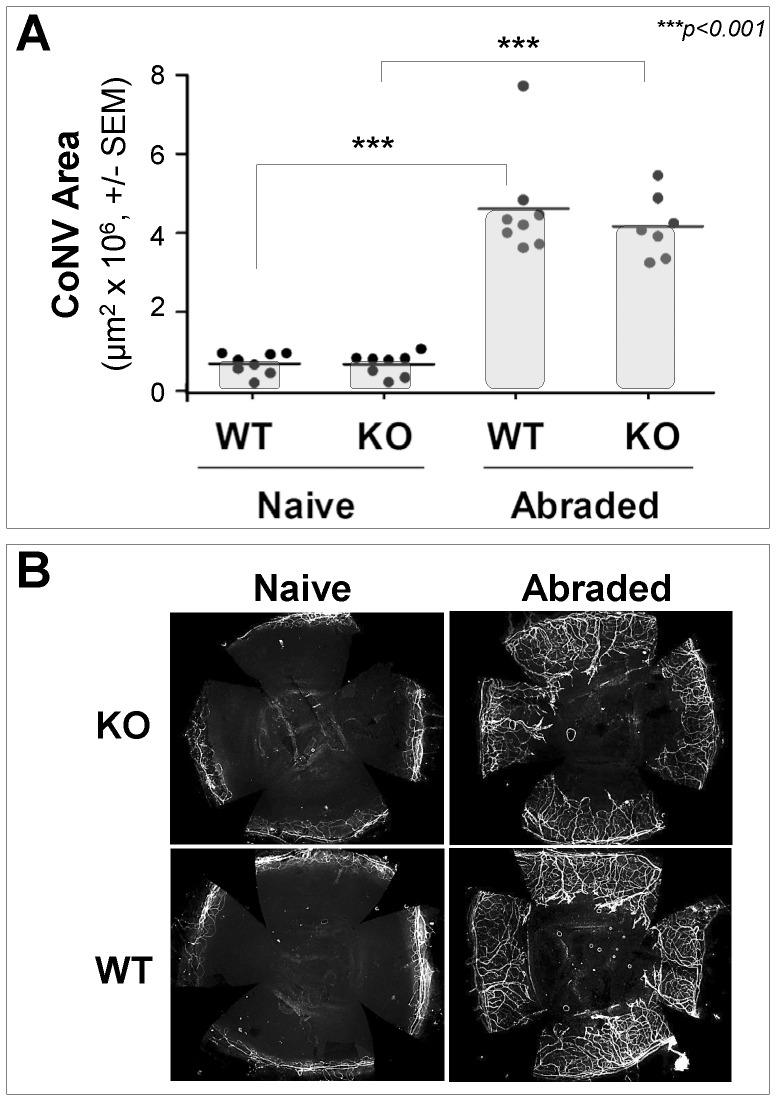
Mouse CoNV Assay.A) Adult Myd88−/− (KO) and littermate Myd88+/+ (WT) mice (N = 7 to 8 animals/group) were subjected to corneal abrasion on Day 0. On Day 21 post-abrasion animals were euthanized and CoNV area (+/− SEM) was measured by fluorescence microscopy, as described in Materials and Methods. Statistical analysis was performed using two-way ANOVA. Within each genotype, the abraded group was significantly different from the naïve group (p<0.0001). However, comparison between the two genotypes showed no significant effect of the Myd88 deficiency on CoNV area in response to abrasion. B) Representative images of the 4 groups shown in Figure 6A.